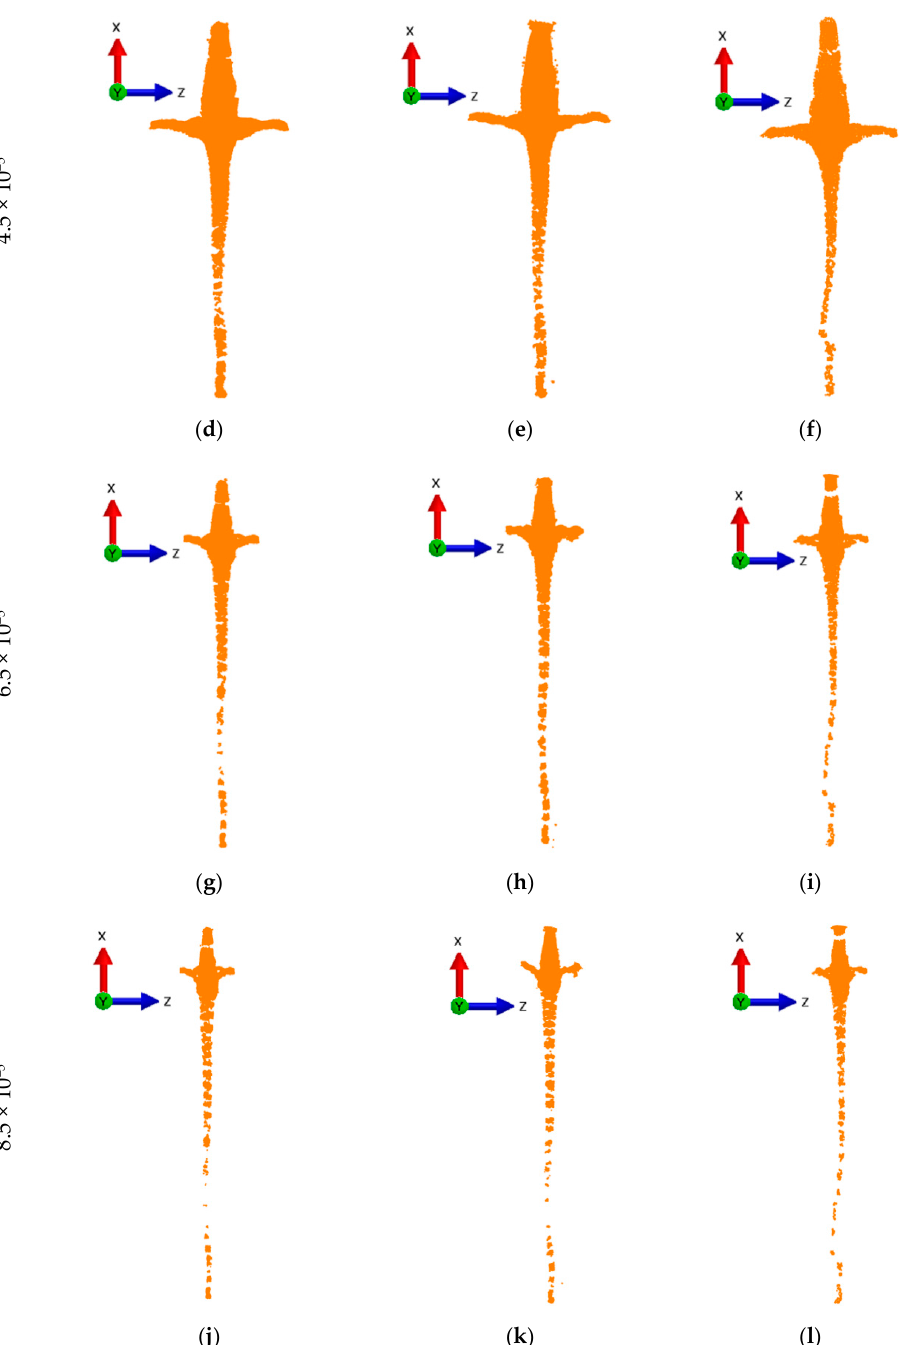
Figure 14. Time steps of the three types of Ł K charges analyzed: ( a – c ) time step for t = 2.5 × 10 − 5 ; ( d – f ) time step for t = 4.5 × 10 − 5 ; ( g – i ) time step for t = 6.5 × 10 − 5 ; ( j – l ) time step for t = 8.0 × 10 − 5 .